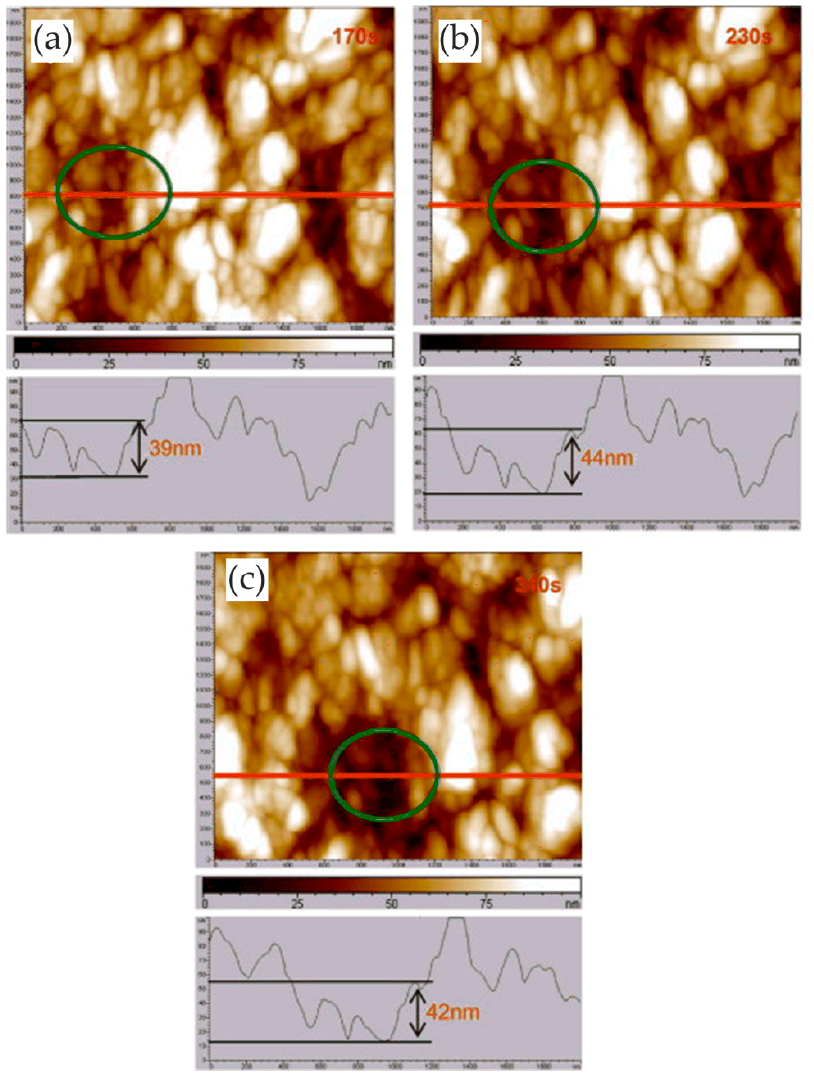
Figure 31. In situ AFM images of nanocrystalline (NC) thin film in the initial pitting stage under anodic polarization in 3.5 wt% NaCl solution: ( a ) 170 s; ( b ) 230 s; ( c ) 340 s. Reprinted with permission from Reference [71]; copyright 2013 Elsevier Ltd.